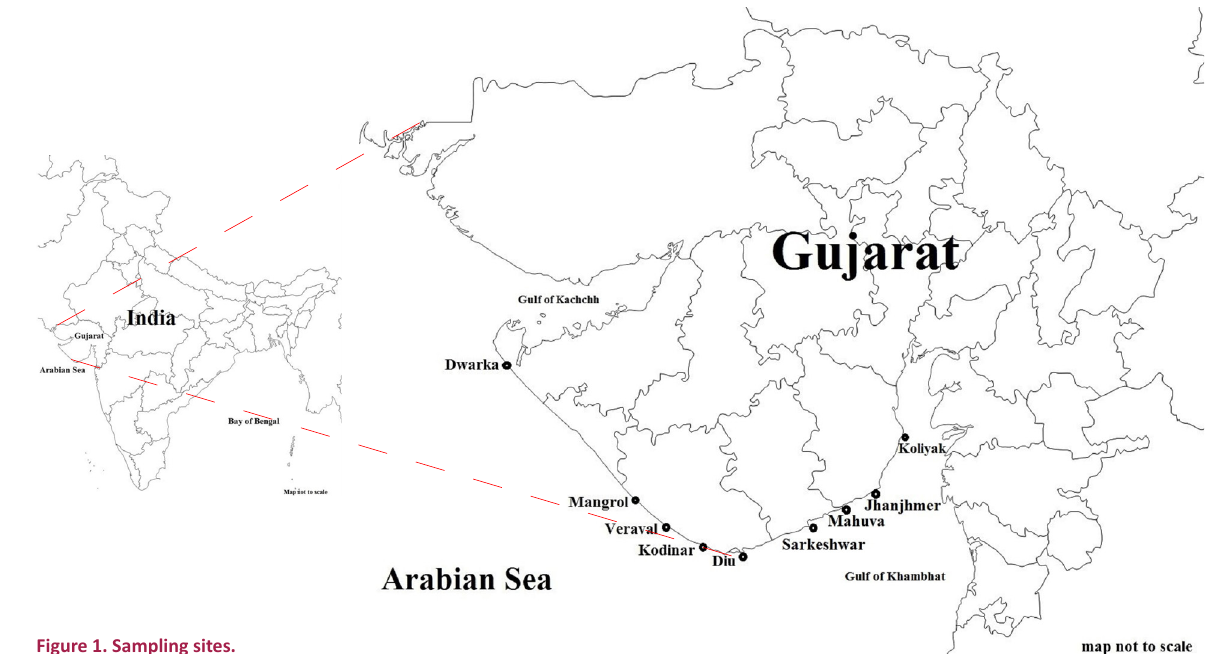
Figure 1. Sampling